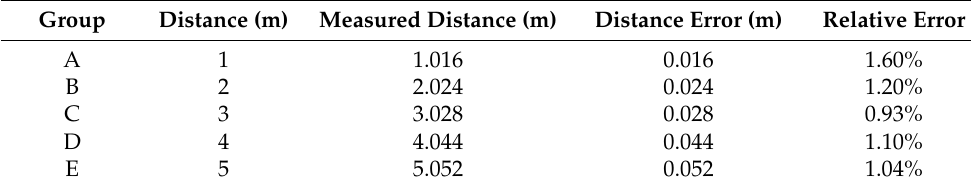
Table 2. Experimental platform distance test results.